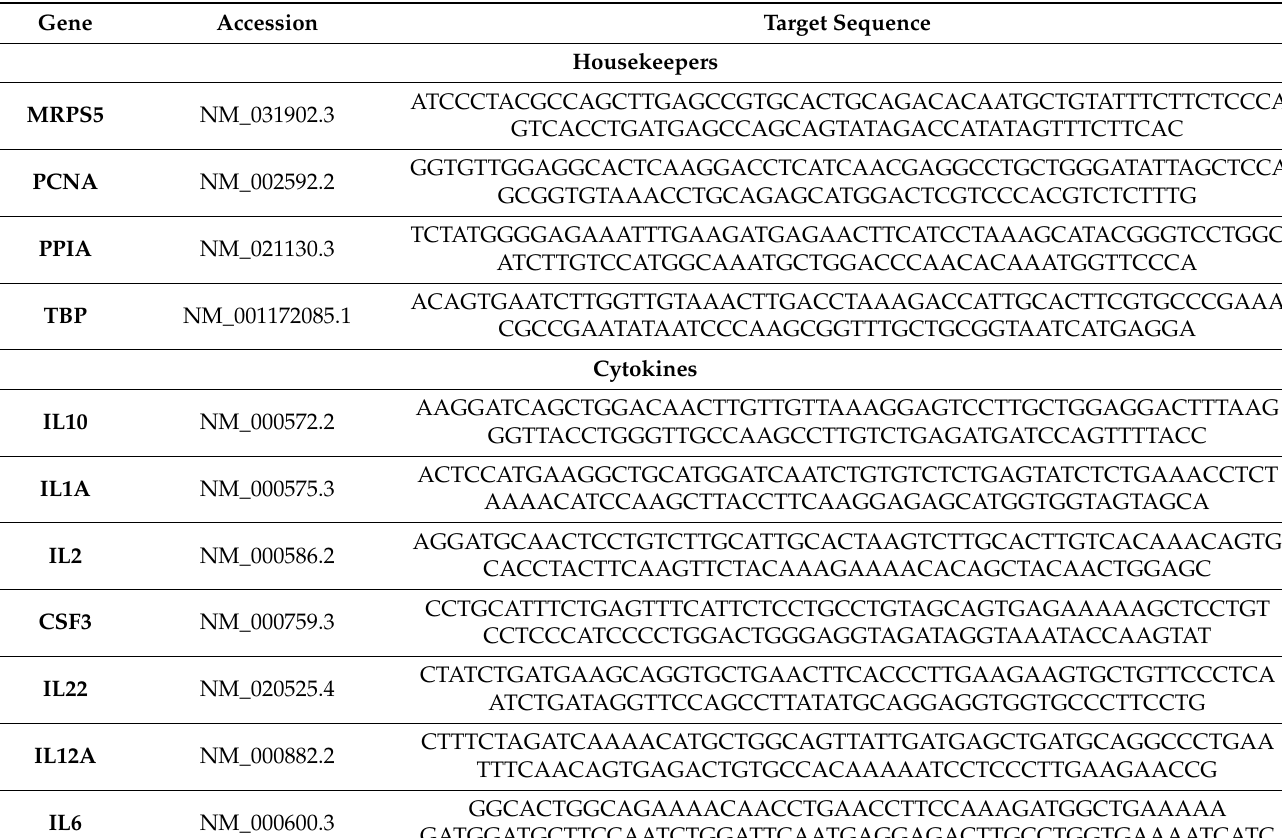
Table 2. NanoString